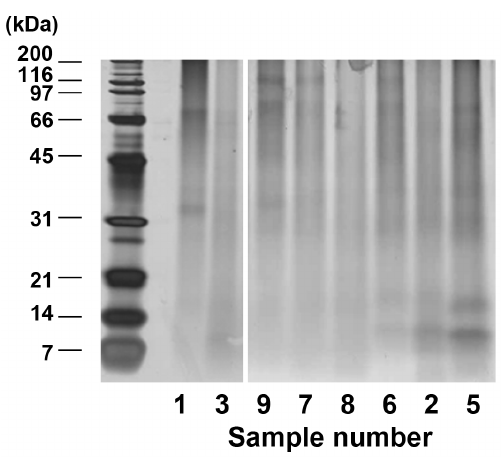
Figure 1. Analysis of proteins extracted from CaOx kidney stones by SDS-PAGE. CaOx kidney stones obtained from 8 individuals were solubilized, dialyzed, concentrated, and then the extracts containing 0.2 m g protein each were subjected to SDS-PAGE. Proteins were visualized by silver staining. Sample 4, the yield of which was , 0.1 m g/mg stone, also showed similar diffused protein pattern (data not shown). Electrophoresis and staining were carried out three times, and all gave similar results.